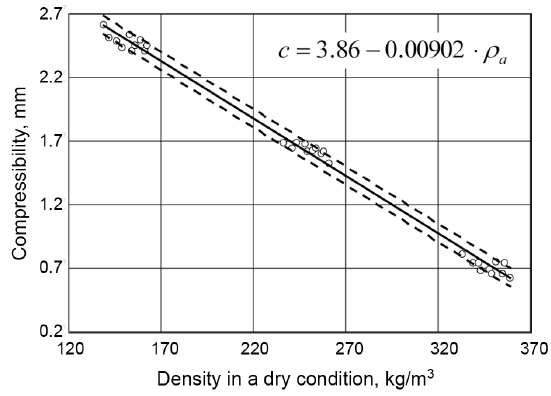
Fig. 3. The relationship between compressibility and density of lightweight composite: ○ — experimental data; (——) – regression line; (- - - -) – projected minimal and maximal values The compressibility of less dense lightweight com-